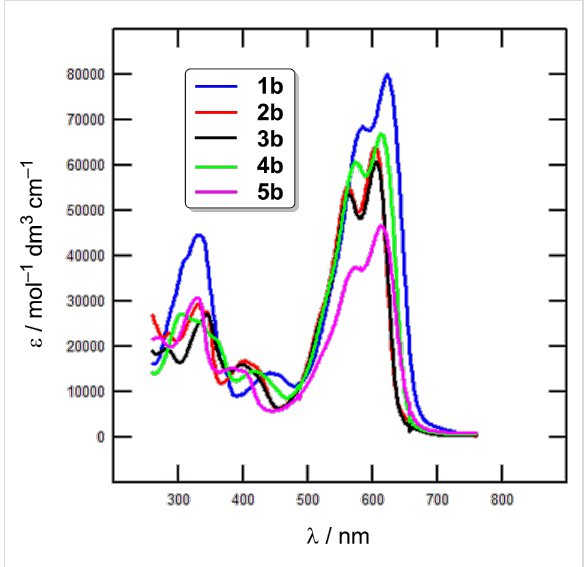
Figure 5: UV–vis absorption spectra of chromophores 1b – 5b in 1,4- dioxane at a concentration of 1 × 10 − 5